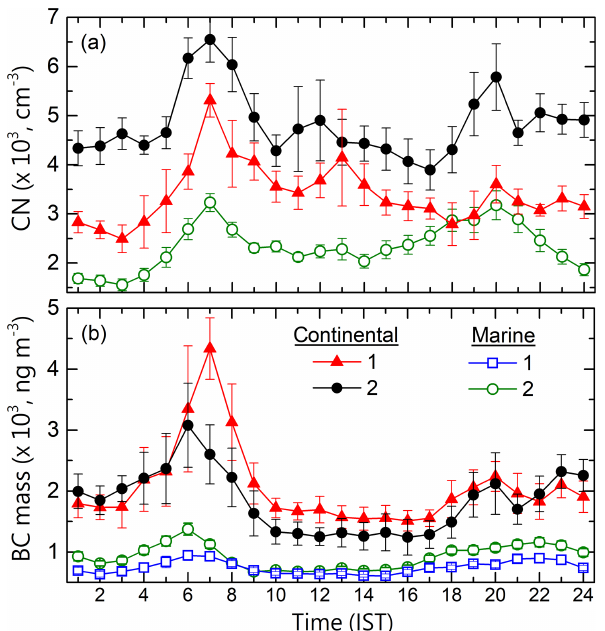
Figure 6. Diurnal variations of (a) CN and (b) BC concentrations during marine and continental conditions.